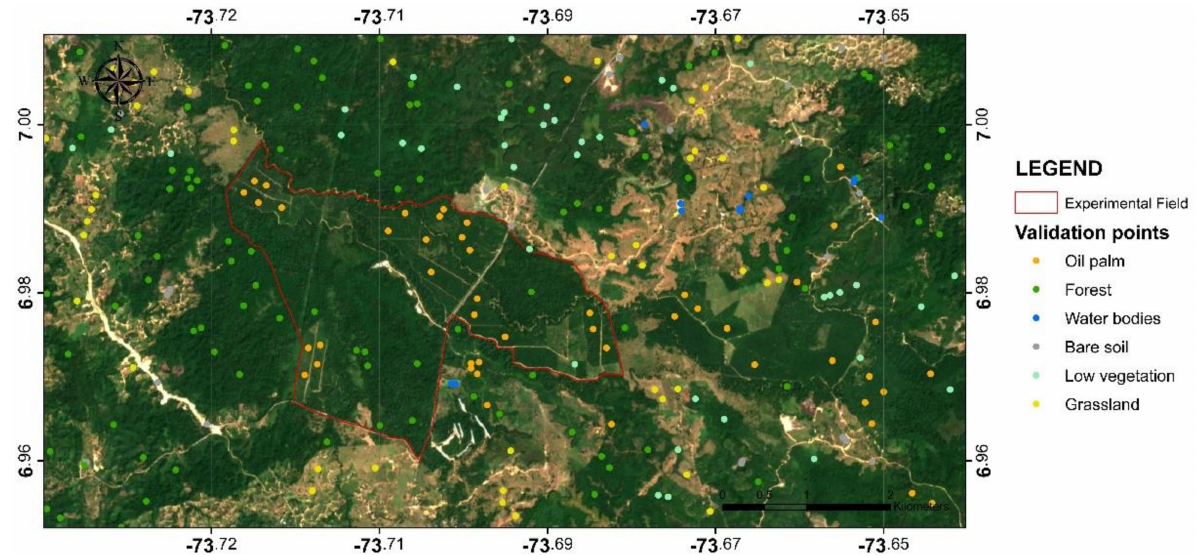
Figure 3. Location of ground truth points for the validation process of land cover classification.